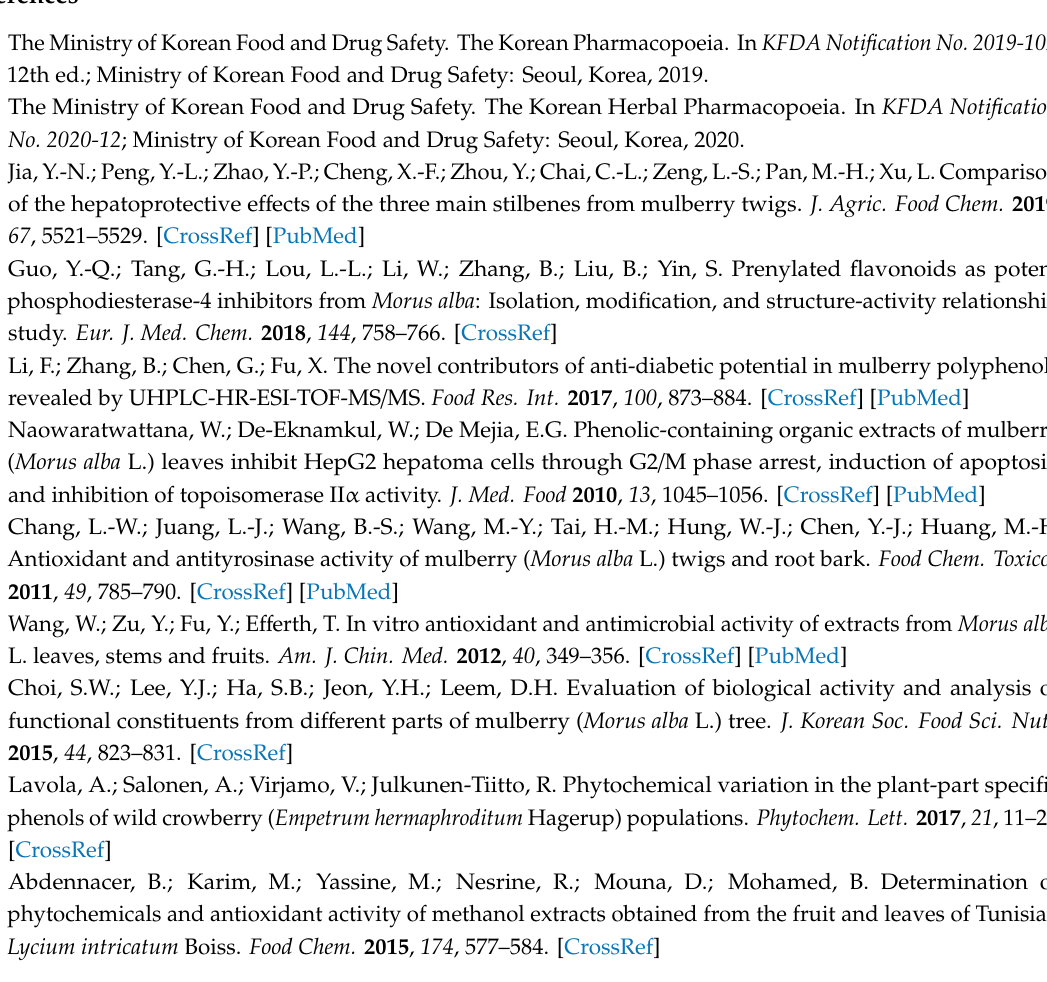
Supplementary Materials: The following are available online, Figure S1: chromatograms of twelve marker compounds at the detection wavelength of UV 265 nm, Table S1: Intra- and interday precisions of the marker compounds, Table S2: Recoveries of the marker compounds (n = 3), Table S3: Mean contents (mg / g) of the marker compounds in the extracts of the Morus samples, Table S4: The samples of di ff erent medicinal parts of Morus alba